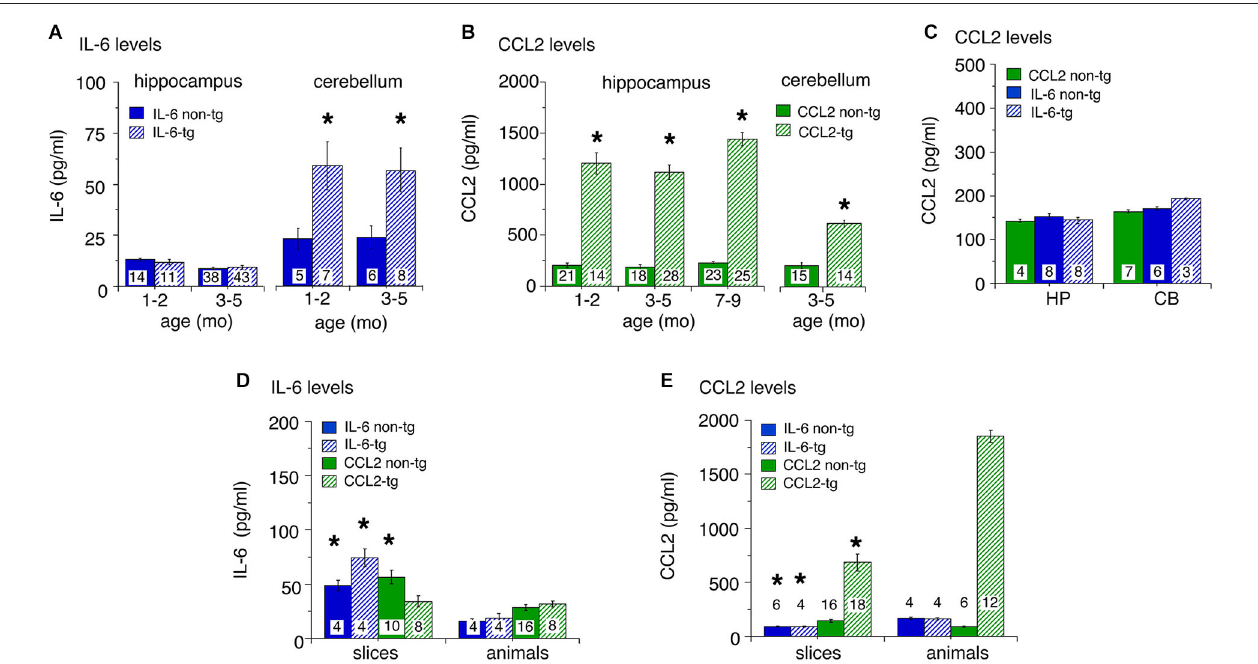
significant difference ( p < 0.05, unpaired t -test) from non-tg of the same treatment group. (D,E) IL-6 (D) and CCL2 (E) levels in hippocampal samples with in vitro incubation (slices) or without (animals). For slices, numbers in bars are the number of samples measured (two samples/animal; left and right hippocampus). For animals, numbers in bars are the numbers of animals measured. * = statistically significant difference ( p < 0.05, unpaired t -test) between slices and animal samples of the same